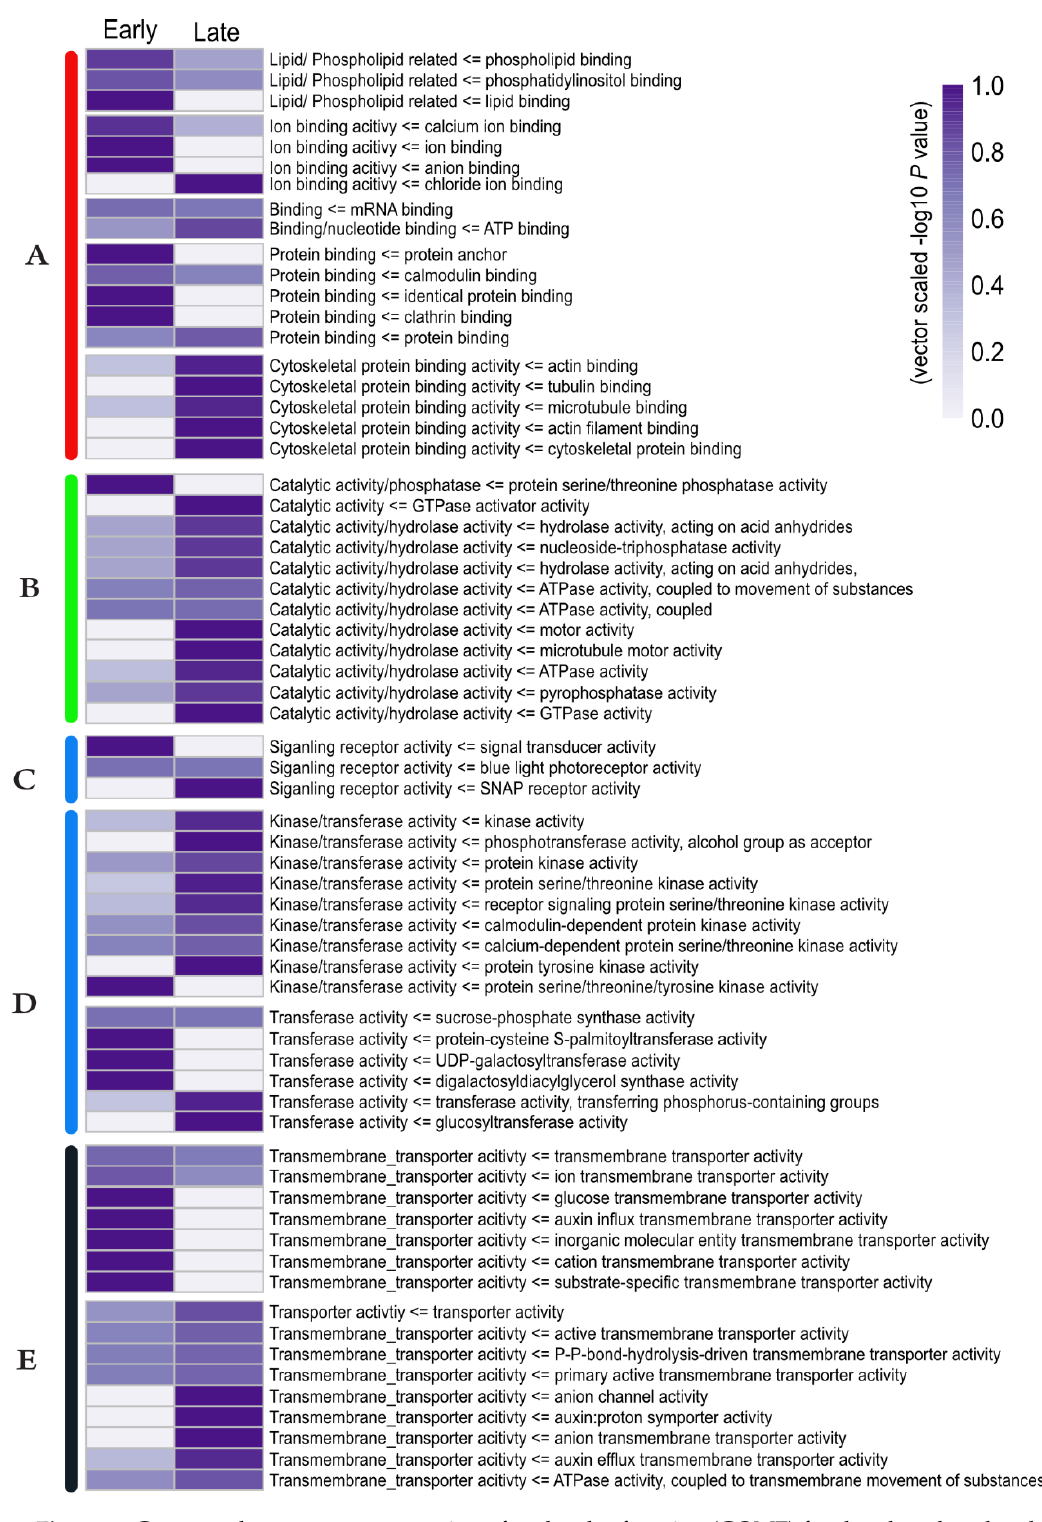
Figure 3. Gene ontology overrepresentation of molecular function (GOMF) for the phosphorylated proteins under cold exposure. Negative log 10 p -values of the GO terms enriched in the K-means clusters mentioned in Figure 2 were vector-scaled and visualized. Sub-clusters ( A – E ) are based on the similarity of GO terms extracted from ReViGO. Early, GO terms enriched within 5 to 15 min of cold exposure; Late, GO terms enriched within 30 to 60 min of cold exposure.